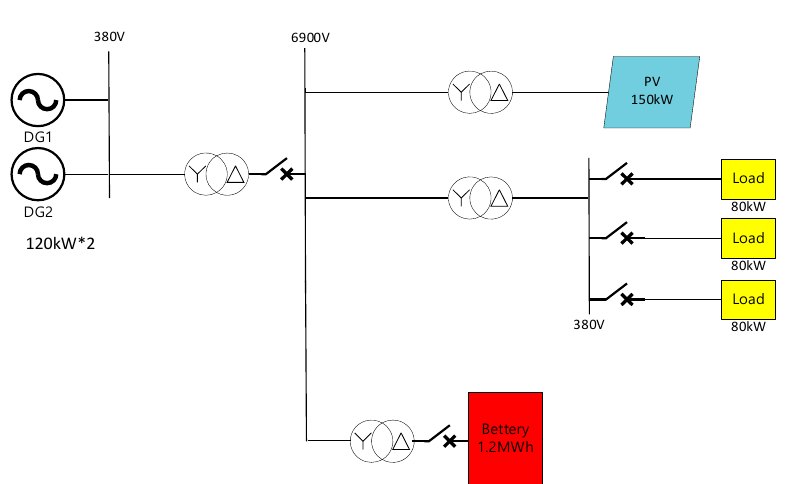
Figure 3. The existing Marado Island Power Grid .